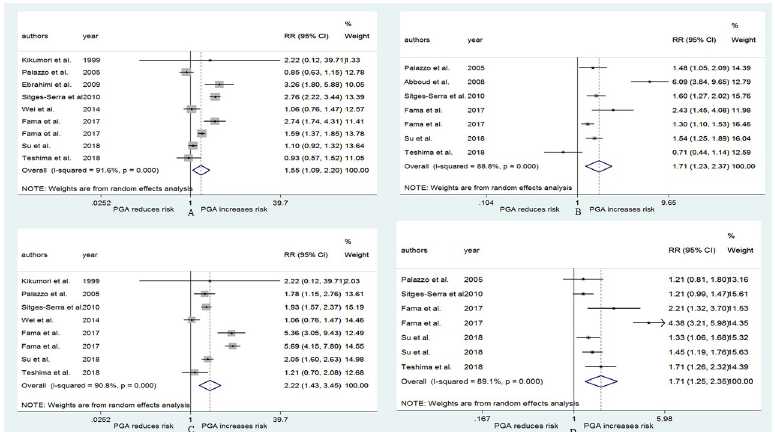
Fig 6. RR for postoperative hypoparathyroidism in patients who underwent different number of PGA. (A) two or more vs one or less. (B) two or more vs one. (C) two or more vs zero. (D) one vs zero.